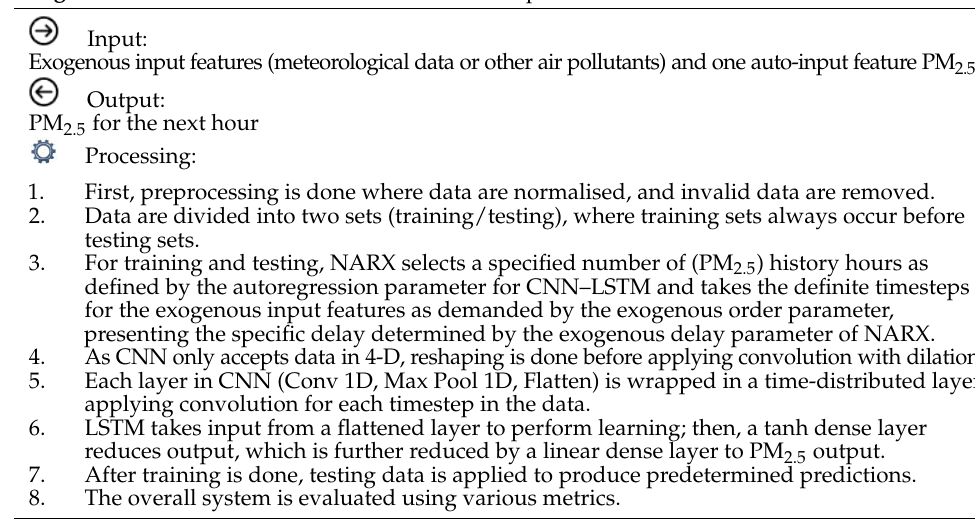
Figure 4. An overview of CNN – LSTM NARX proposed layers.